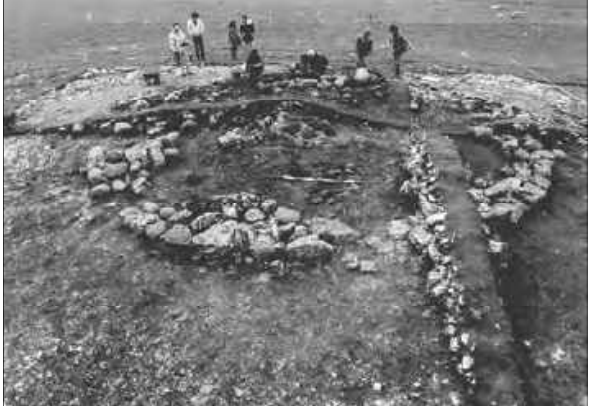
Fig 2.18 Excavations at Hardendale Nab, Cumbria (OA